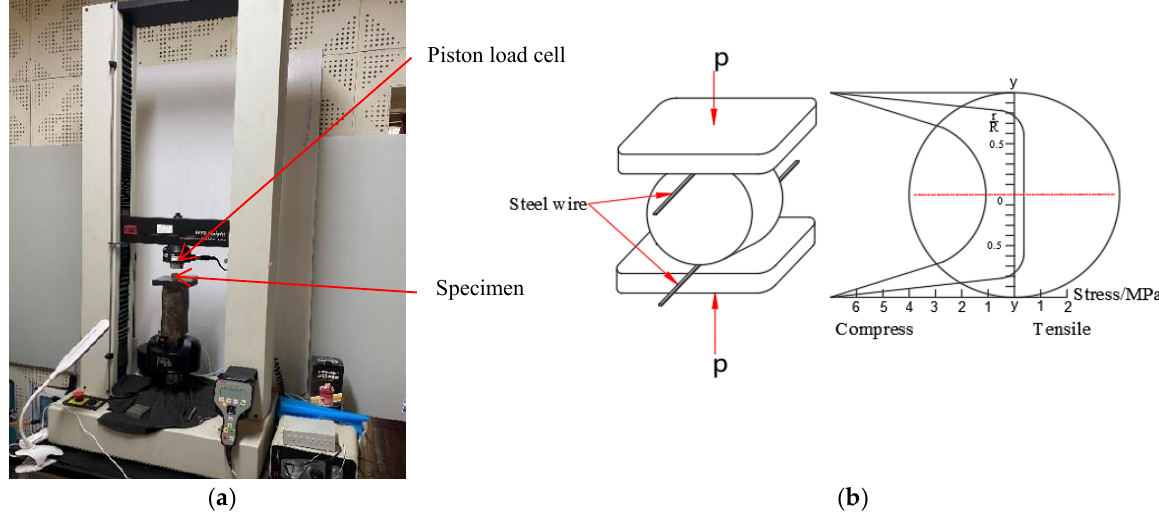
Figure 5. Brazilian splitting test device and principle. ( a ) Device for the Brazilian splitting test and ( b ) diagram of loading and stress distribution in the splitting test.